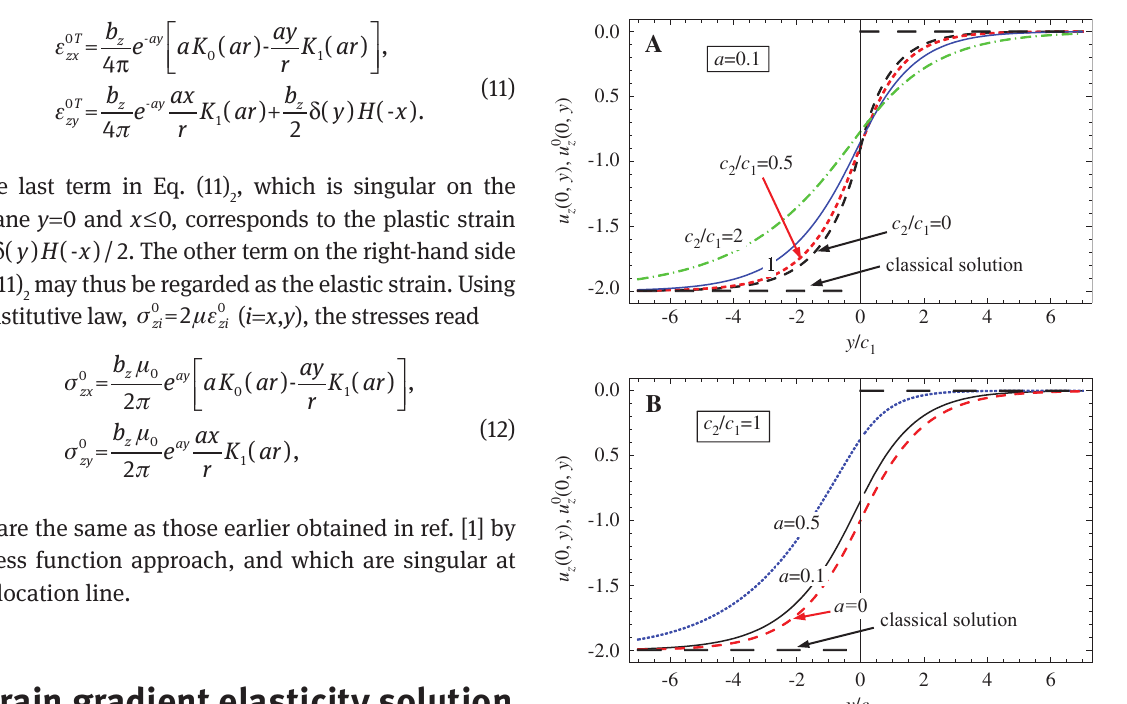
(0, y ) in units of b z